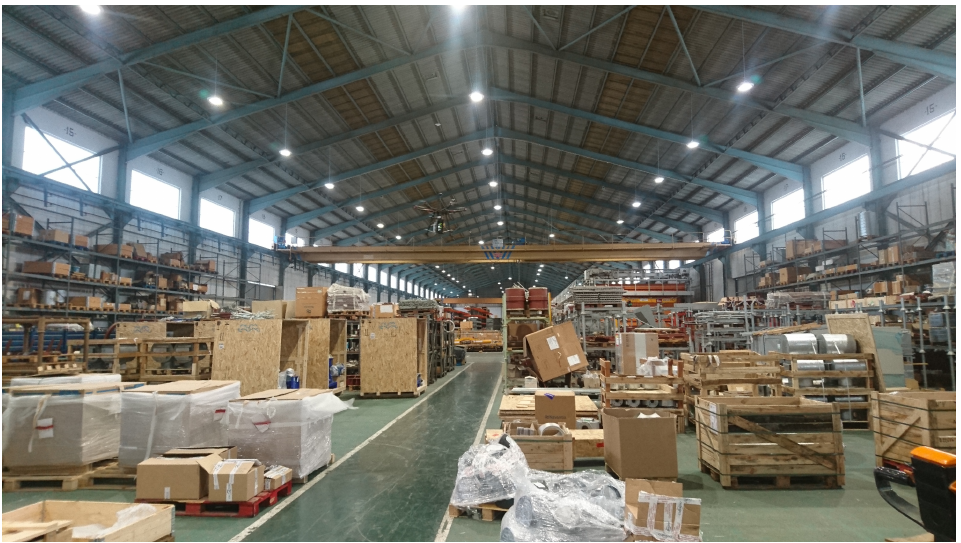
Figure 7. Warehouse where the experiments were performed.